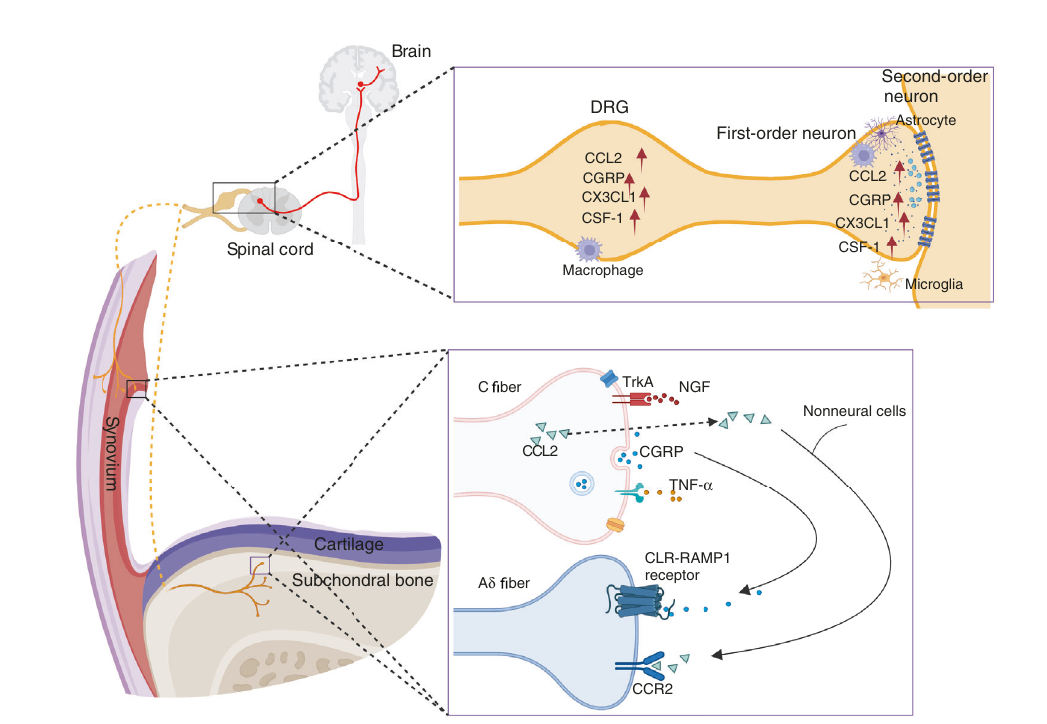
Fig. 2 The NGF, CGRP, CCL2/CCR2, and TNF α signaling pathways in OA-associated pain. NGF acts on its receptor TrkA and mediates pain transmission. CGRP is released from C- fi ber terminals and binds with calcitonin receptor-like receptor (CLR) and receptor activity-modifying protein 1 (RAMP1) on adjacent A δ nerve fi bers. High expression of chemokines, such as CCL2 and CX3CL1, and other immune mediators, such as colony-stimulating factor 1 (CSF-1) and CGRP, was detected in the DRG and dorsal horn of the spinal